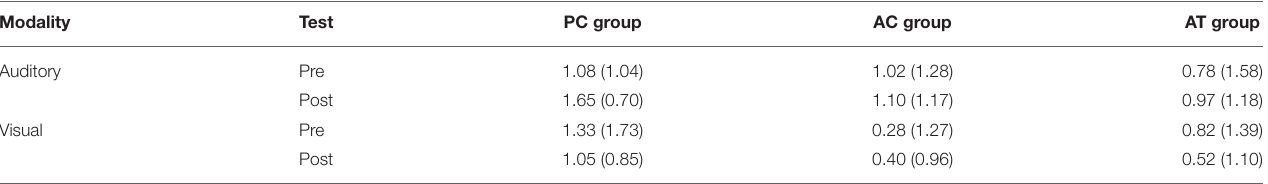
TABLE 4 | Irrelevant speech effects (digit span during speech subtracted from digit span during noise) for the visual and auditory serial recall task at pre- and post-test in old adults.